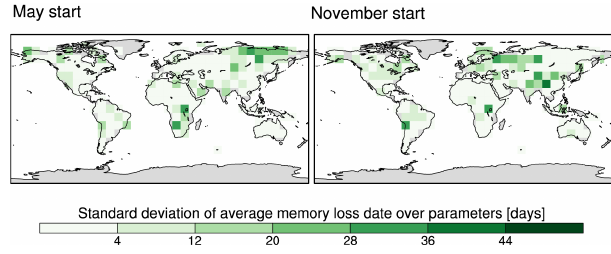
Figure 3. Standard deviation in the top model soil level, estimated from H-TESSEL, for May (left) and November (right) start